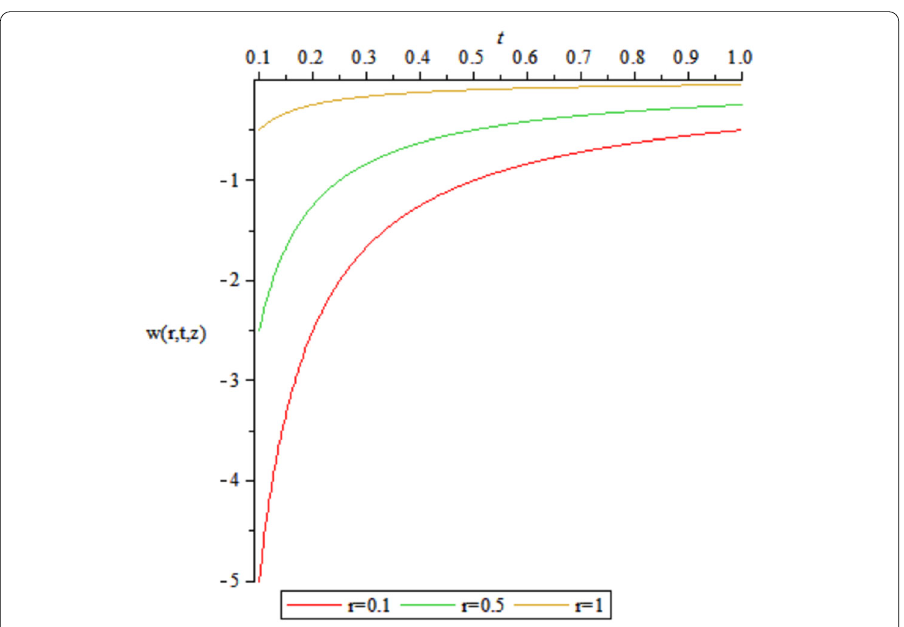
Figure 9 Velocity component w ( r , t , z